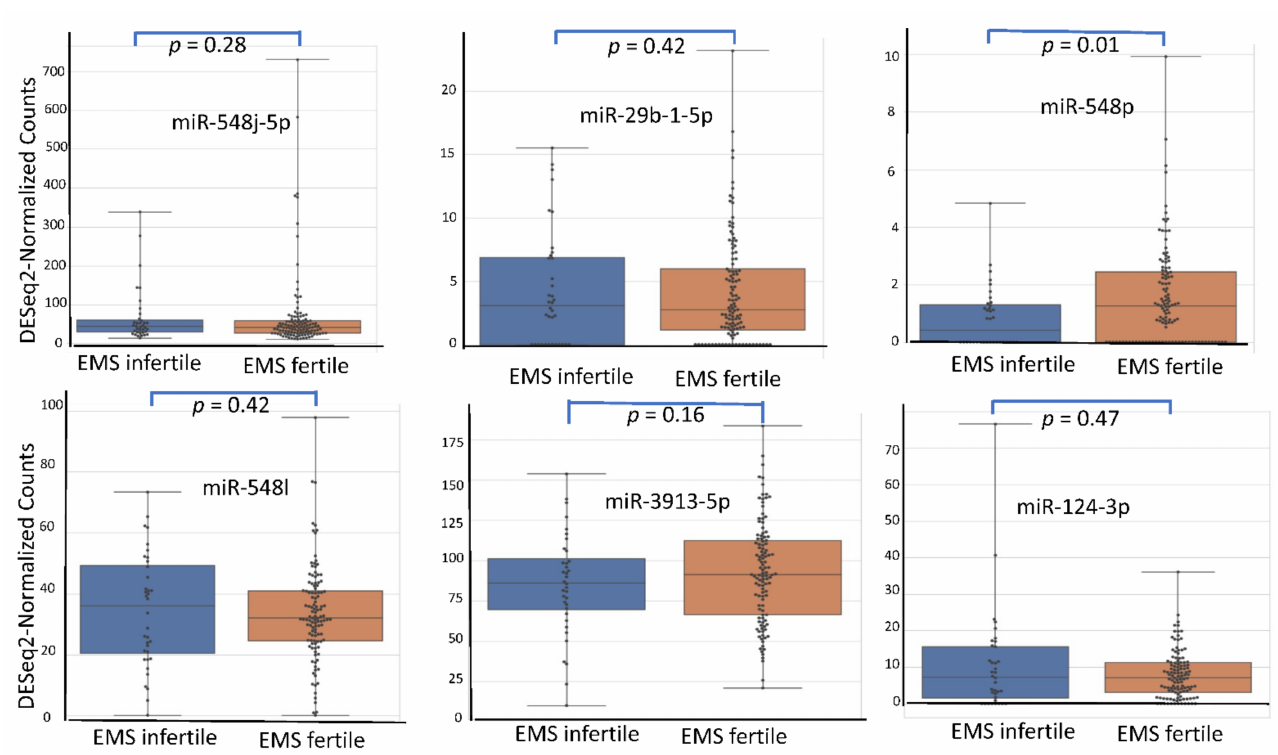
Figure 4. miRNA expression level according to fertility status.